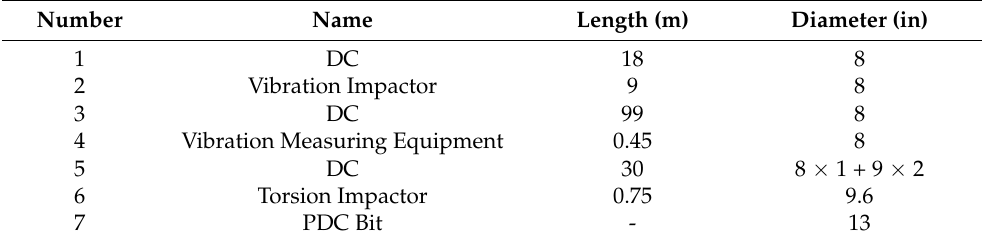
Figure 1. Schematic diagram of installation of drilling tool assembly and vibration measuring equipment. Table 1. Drill tool assembly size.